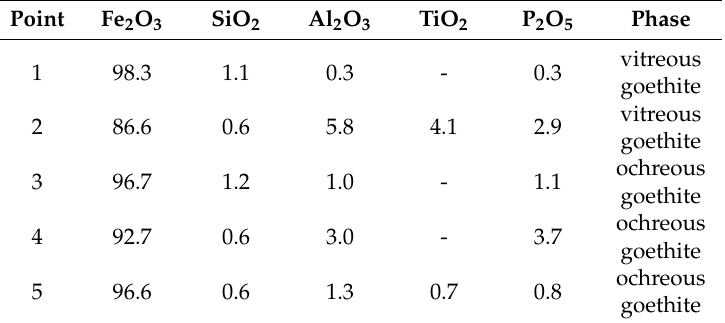
Table 4. EDS analysis from Figure 5, wt %.